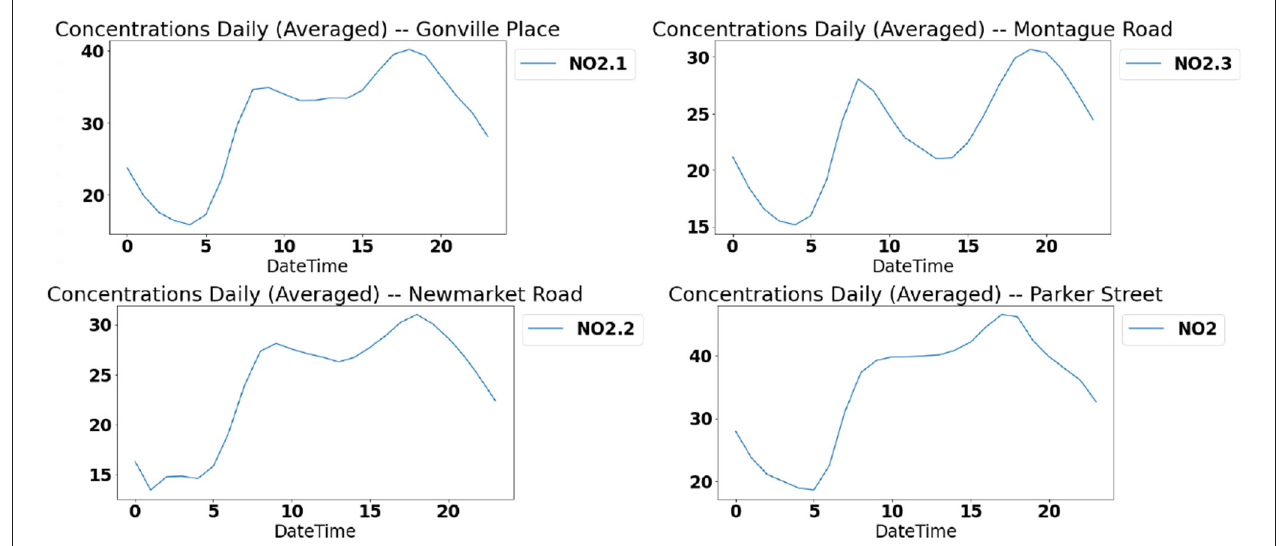
FIGURE 7 | Daily NO 2 trends: concentration trends across four different locations.